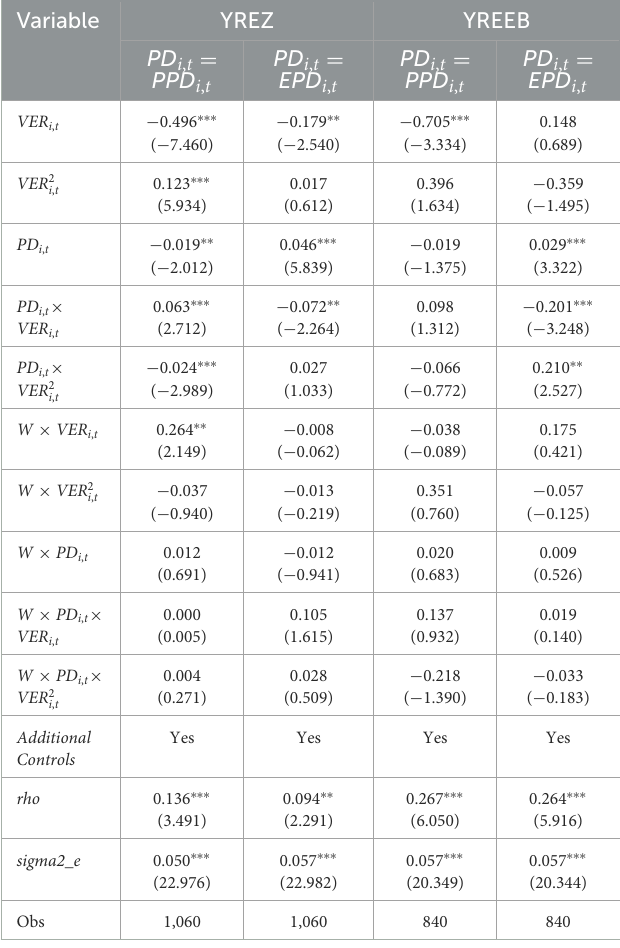
TABLE 13 The results of the moderating effect of PD on the green governance effect of VER in the two economic belts.